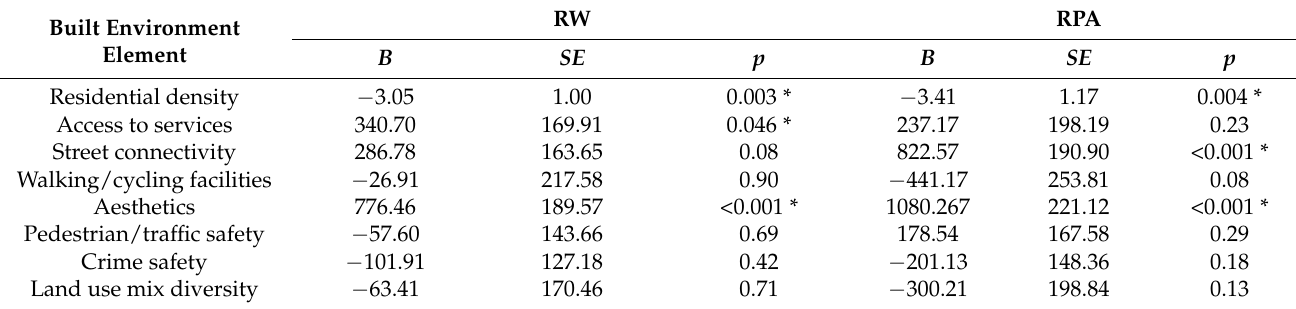
Table 3. Association of built environment with older people’s RW and RPA in the city of Yiwu. Built